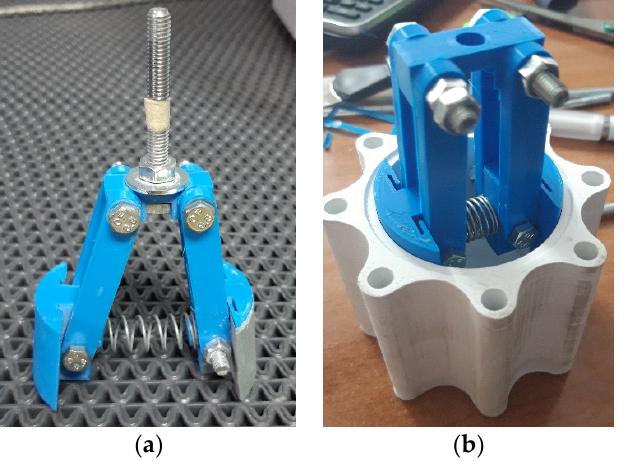
Figure 6. ( a ) The tool for the sanding process; ( b ) The preparation of the cylinder body and the tool for the sanding